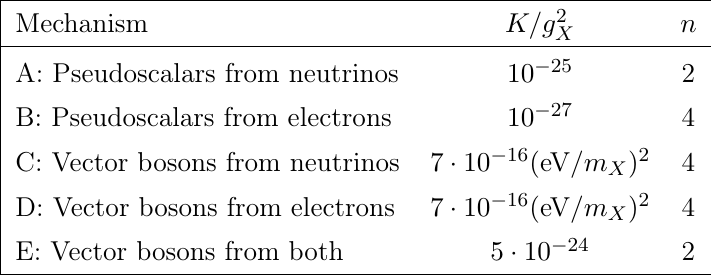
Table 1 . Different production mechanisms. This table gives an overview about the different production mechanisms for the light boson X and their effect on the spectrum, caused by different forms for K and n . The values stated are approximations for eV-scale light bosons. or neutrinos.